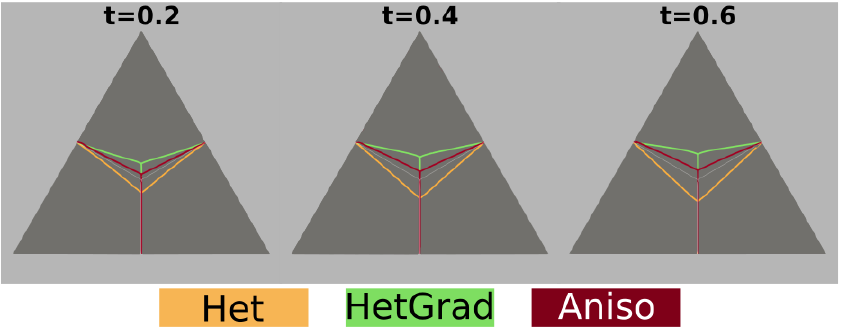
Figure A4. Interface evolution using the Het, Hetgrad, and Aniso formulations of the triple junction with r = 1.66.